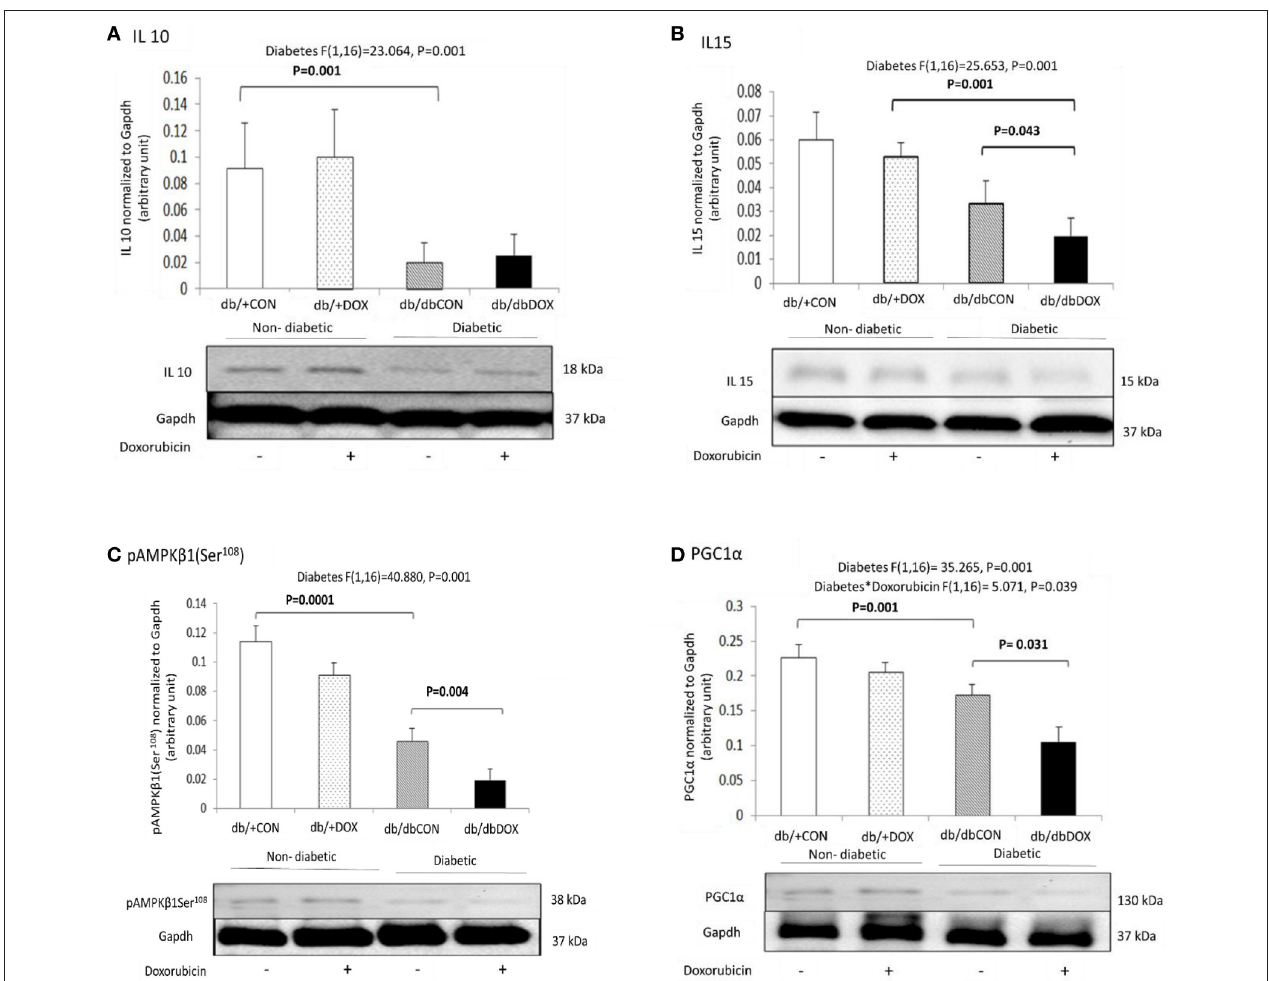
FIGURE 3 | Non-diabetic and diabetic skeletal muscle anti-inflammatory microenvironment after DOX exposure examined by phosphorylation of myokines: IL10 (A), IL15 (B) AMPK β 1Ser108 (key regulator) (C) and PGC1 α (transcription factor) (D) are shown. Data are expressed as mean ±